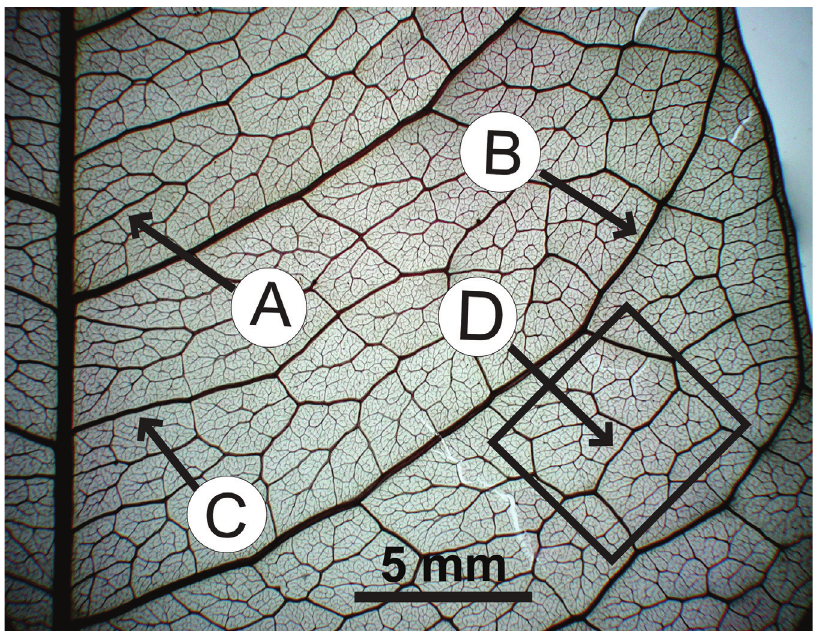
Figure 7. Leaf architecture of Spondias mombin. A Epimedial tertiaries B Somewhat arcuate secondary